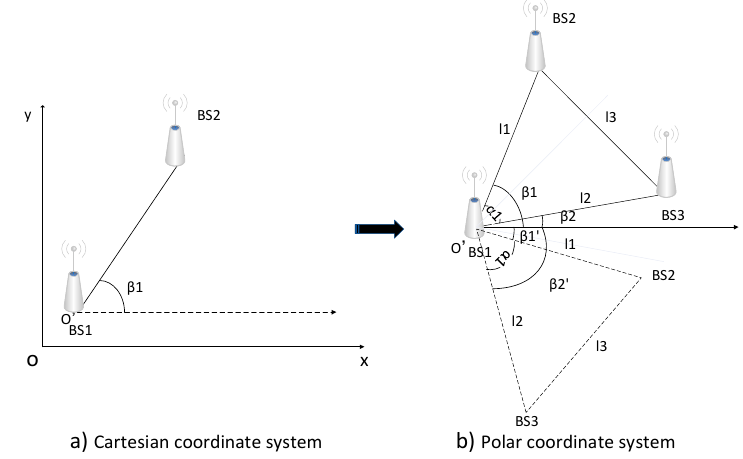
Figure 6. Coordinate system transformation process.